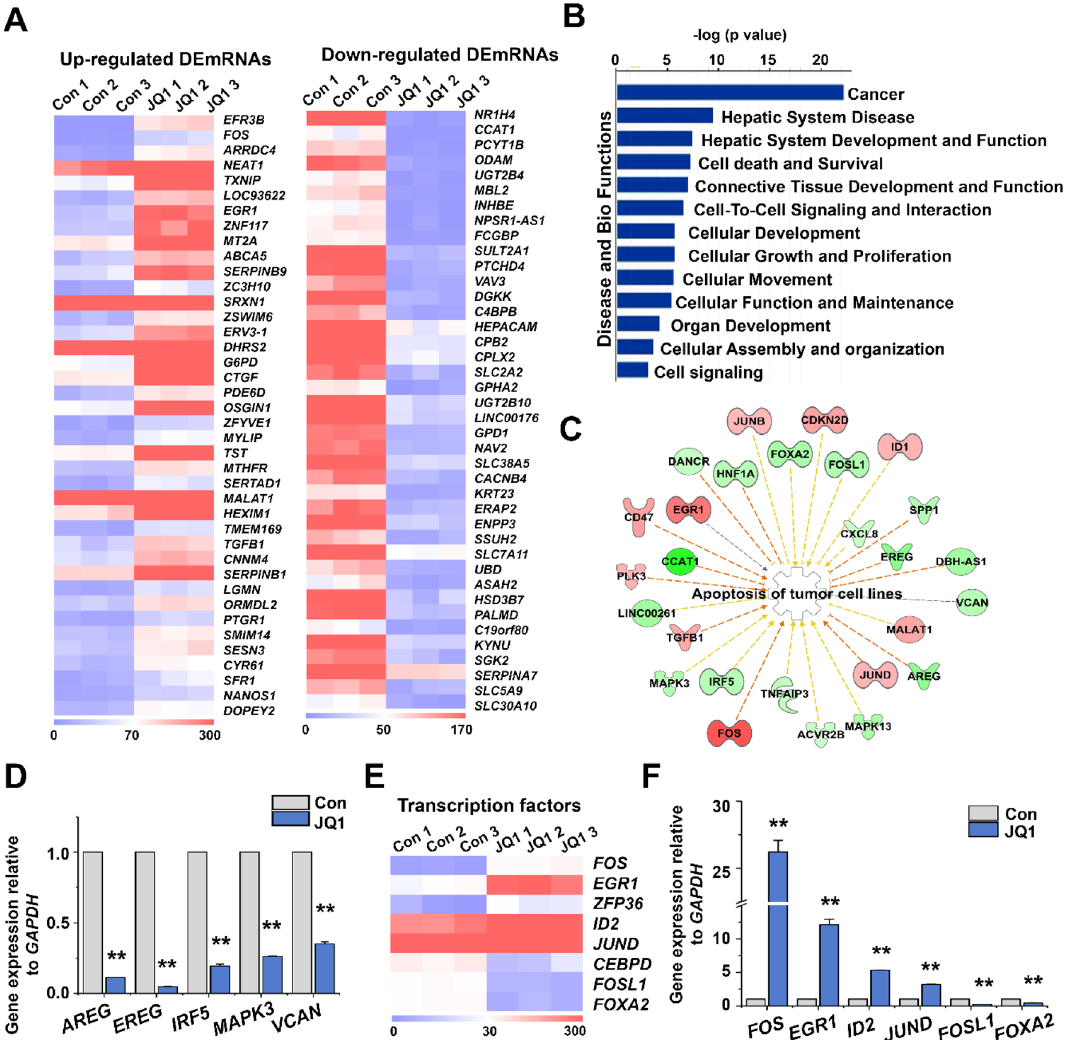
Figure 3. Expression of DEmRNAs and selected TFs in JQ1-treated vs. control HepG2 cells. ( A ) Heat map representing the top 40 up- and down-regulated DEmRNAs ( p- value < 0.05, log 2 -fold change ≥ 1.5, log 2 - fold change ≤ − 1.5). ( B ) Disease and biofunction analysis of differentially expressed genes using IPA. ( C ) IPA network analysis of tumor cell apoptosis-related genes in JQ1-treated cells. The DEmRNAs are colored according to their predicted activation state following JQ1 treatment, activated (red) or suppressed (green). The arrows indicate predicted relationships: Red leads to activation; yellow, findings inconsistent with the state of downstream molecule. ( D ) qRT-PCR analysis of selected DEmRNAs. The data represent three independent experiments. The values are the mean ± SD of triplicate wells. ** p < 0.01. ( E ) Heat map showing expression of eight selected TF mRNAs in JQ1-treated vs. control cells, each in triplicate. ( F ) Effect of JQ1 on the mRNA levels of FOXA2 and other TFs (qRT-PCR). The values are the mean ± SD of triplicate wells. ** p <